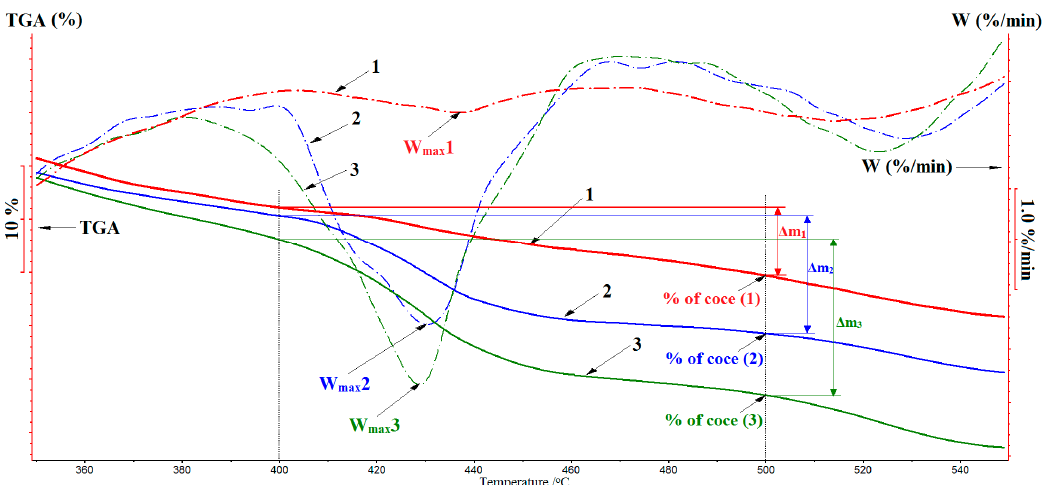
Figure 13. Thermooxidative destruction curves of photocured methacrylated PLA obtained by: 1—laser stereolithography, 2—LED irradiation, 3—mercury lamp irradiation. The weight loss (TGA, %) is shown by solid lines, and the rate of weight loss (W, % / min) is shown by dash-dotted lines. See the photocuring conditions in the Materials and Methods.